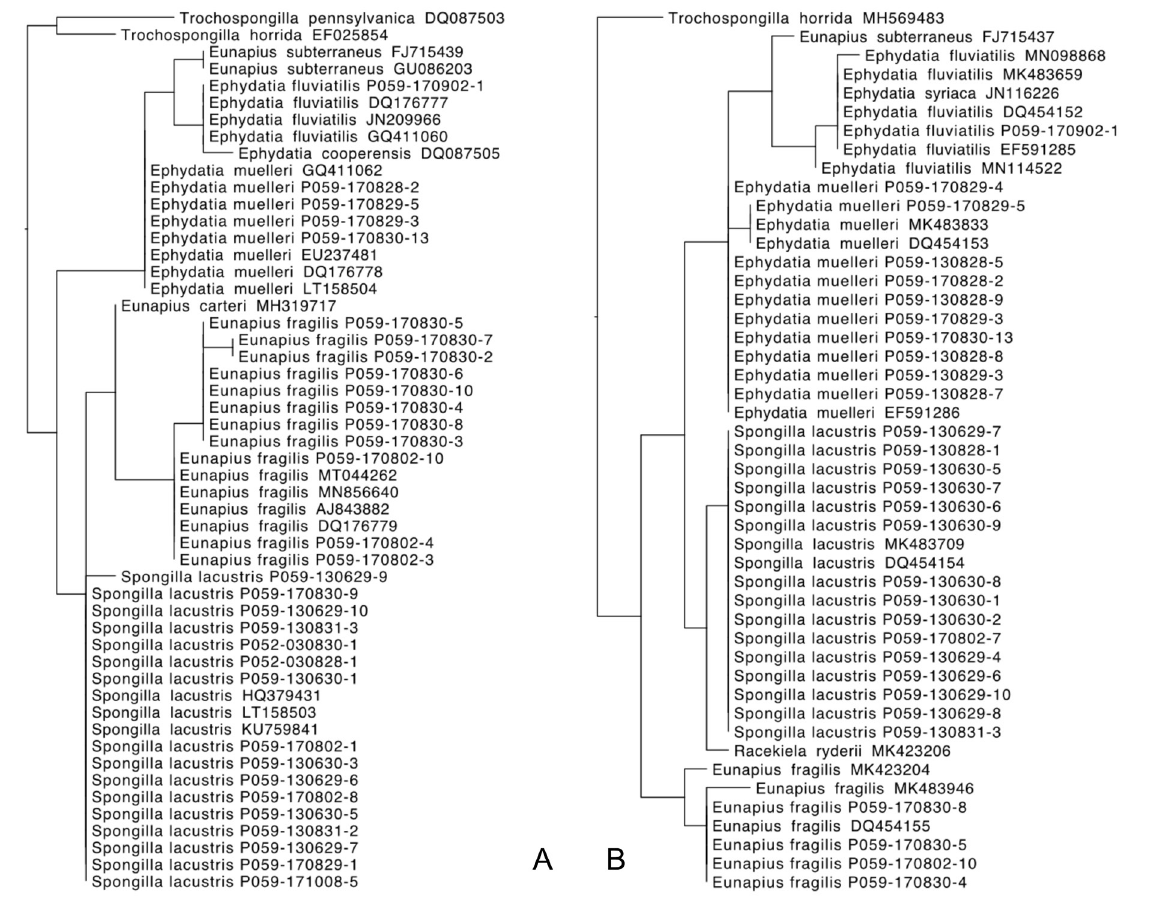
Fig. 6. Neighbor-joining trees based on HKY85 distances. A . coxI dataset. B . 28S dataset. Sequences with a specimen field number (starting with P052- or P059-) are from the present study, remaining sequences are from GenBank with the accession number in the